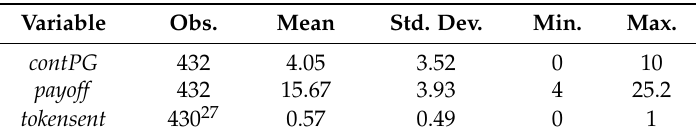
Table 4. Descriptive statistics (2